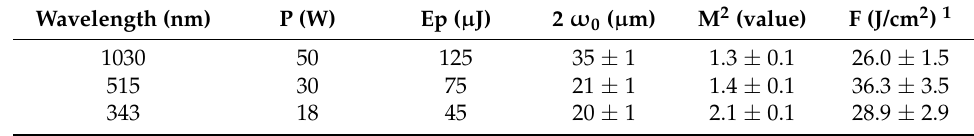
Table 1. Laser beam diameters (2 ω 0 ) and M 2 values measured at the focal points. Measurements were performed using a scanning slit beam profiler (DataRay Beam-Map 2 sensor). The 2 ω 0 values were measured at 1/e 2 of the peak intensity. Output average power (P), pulse energy (E P ), and peak fluence (F) calculated for each wavelength are also given